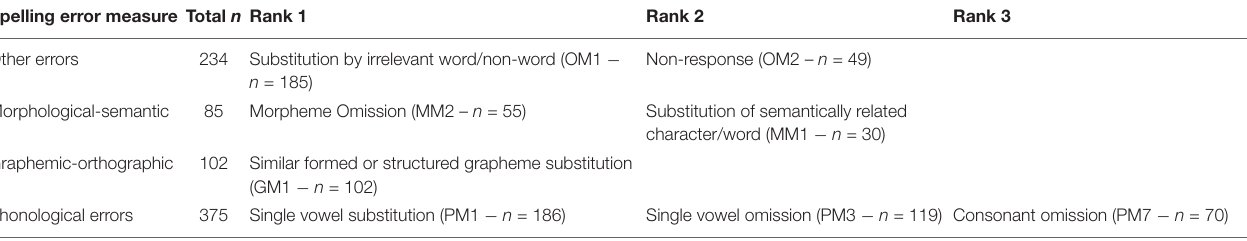
TABLE 7b | Most frequently occurring subtypes of spelling errors within triple-code categories for Malay.